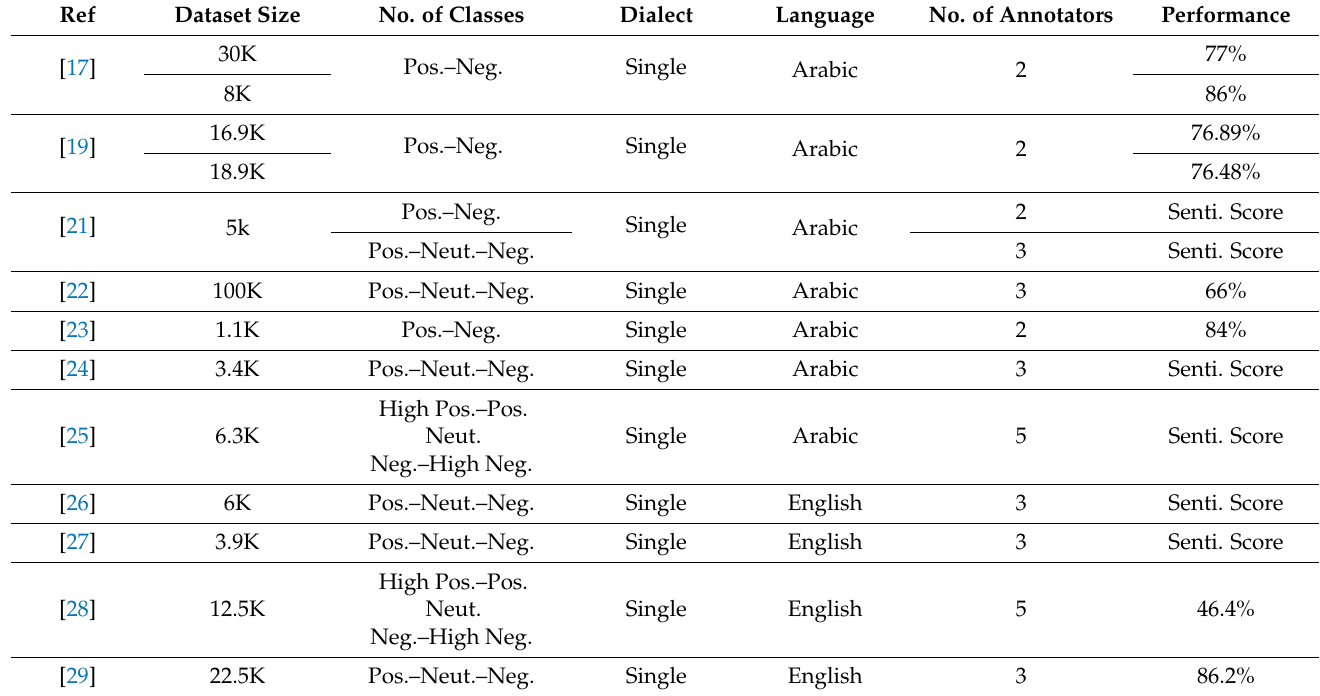
Table 1. Comparison of lexicon-based methods with their performance.